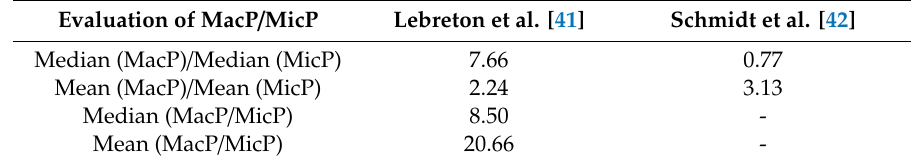
Table 3. Summary of the coe ffi cient, a , which is the ratio of the MacP and MicP mass concentrations. Evaluation of MacP / MicP Lebreton et al.